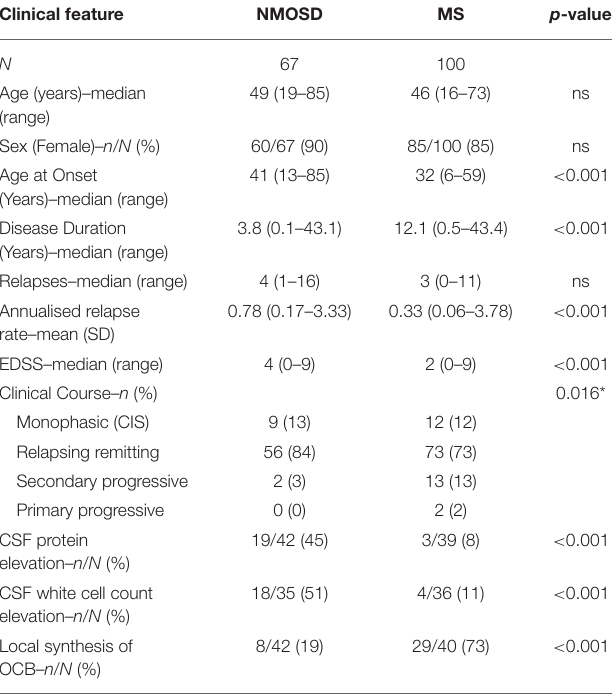
TABLE 2 | Clinical features of NMOSD cases and MS